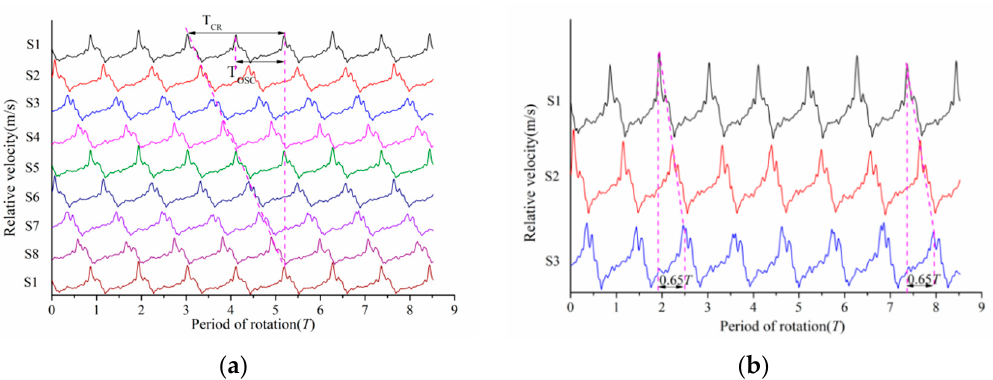
Figure 15. Relative velocity curve of the monitoring point when the flowrate is 0.8 kg/s: ( a ) the curve of the relative velocity at 8 points; ( b ) the curve of the relative velocity at 3 adjacent points.